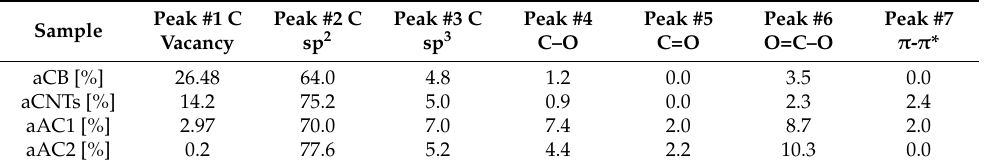
Table 2. Results from the deconvolution of X-ray Photoelectron Spectra (C1s-signal): Areal fractions of the integrated Gaussian-Lorentzian